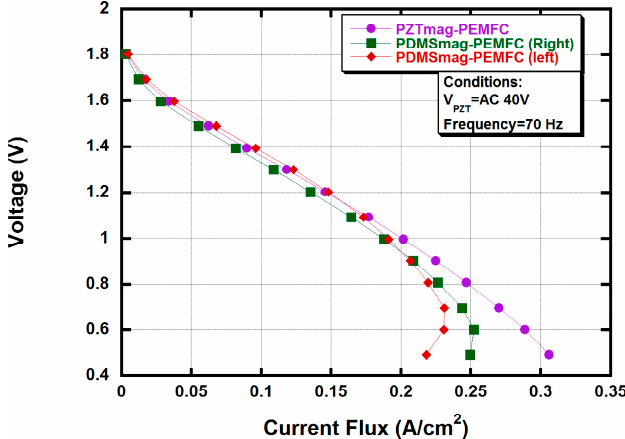
Figure 10. PDMS combined with a magnet within a bi-cell PEMFC.